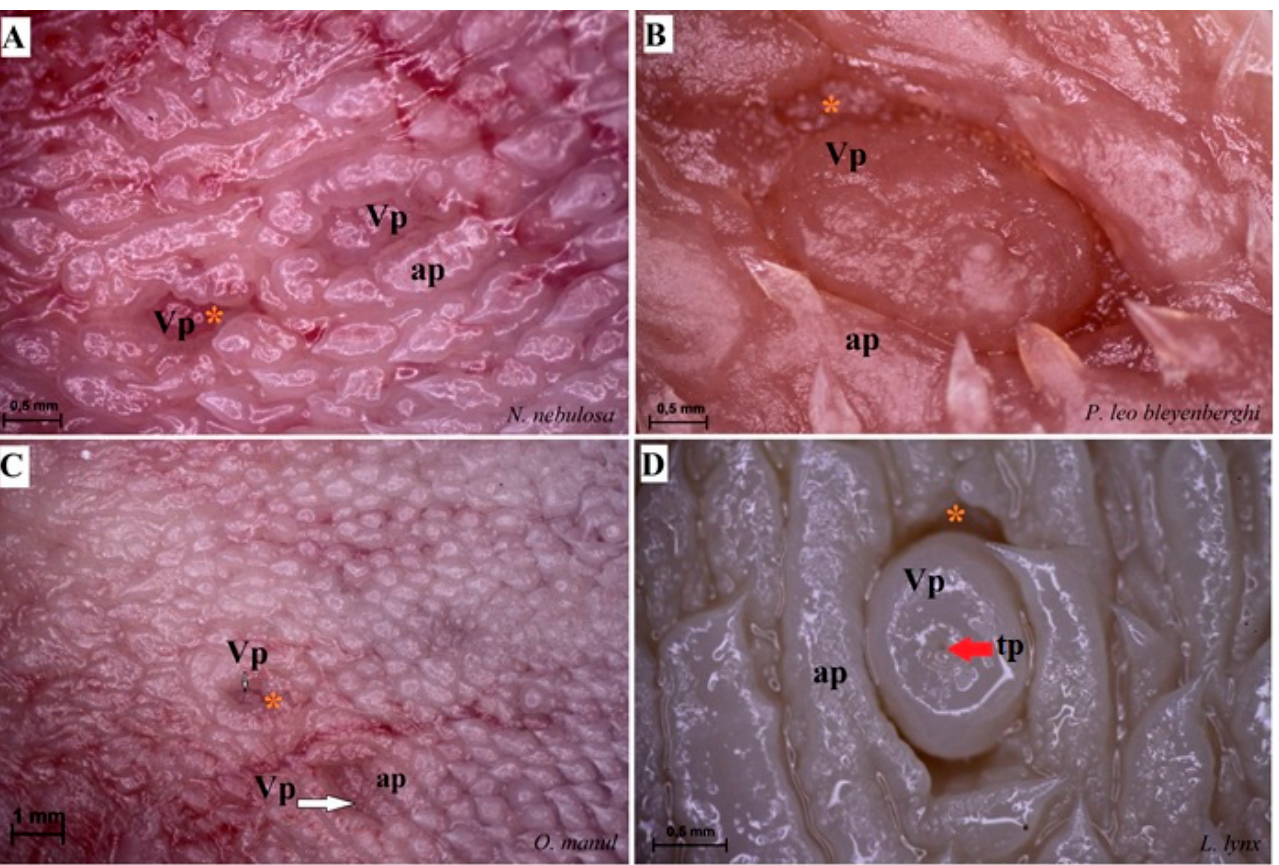
Figure 5. Stereoscopic view of the vallate papillae of the tongue of the four species of undomesticated Felidae: N. nebulosa ( A ), P. leo bleyenberghi ( B ), O. manul ( C ) and L. lynx ( D ). ( A ) Two vallate papillae encircled by papillary groove (asterisk). ( B ) Magnification of the elongate vallate papilla with irregular dorsal surface. ( C ) Two vallate papillae among the numerous filiform papillae. ( D ) Magnification of the round shape vallate papilla with well-visible taste pore (red arrow) of the taste bud on the dorsal surface of the vallum of the papilla. Bar = 1 mm (C); bar = 0.5 mm (A,B,D). Abbre- viations: ap—annular pad with irregular surface, tp—taste pore of the taste bud (red arrow), Vp— vallate papilla (white arrow), * (orange asterisk)—groove of the vallate papilla .